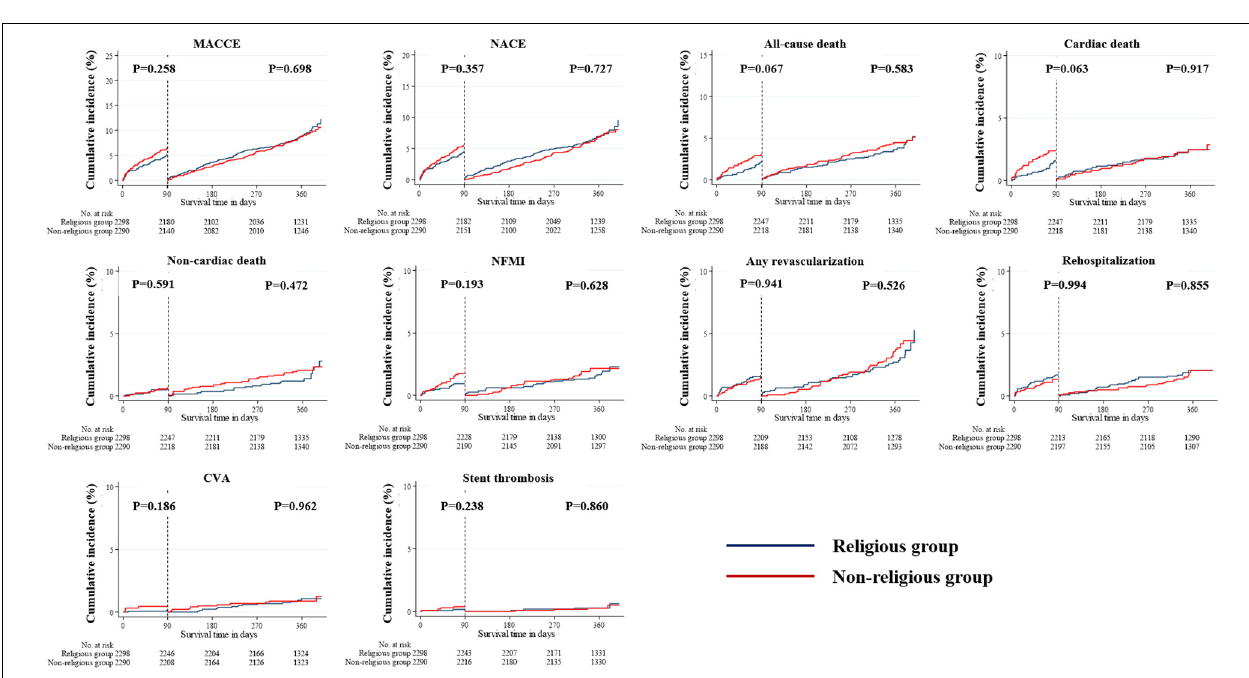
FIGURE 8 | Incidences of primary and secondary clinical outcomes for all patients in a landmark analysis between 90 days and 1 year (after IPTW-adjusted analysis). The figure shows the Kaplan–Meier curves for the cumulative event rates according to their religious faith. IPTW, inverse probability of treatment